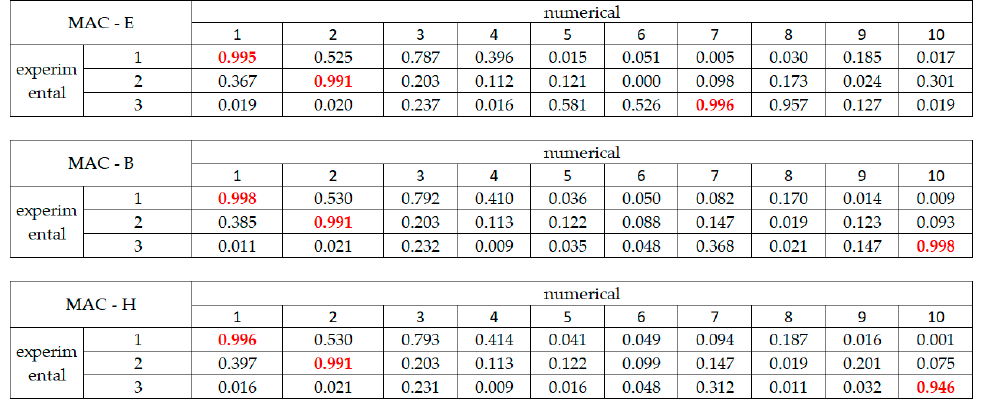
Figure 11. Detail of the MAC matrices associated with different iteration.